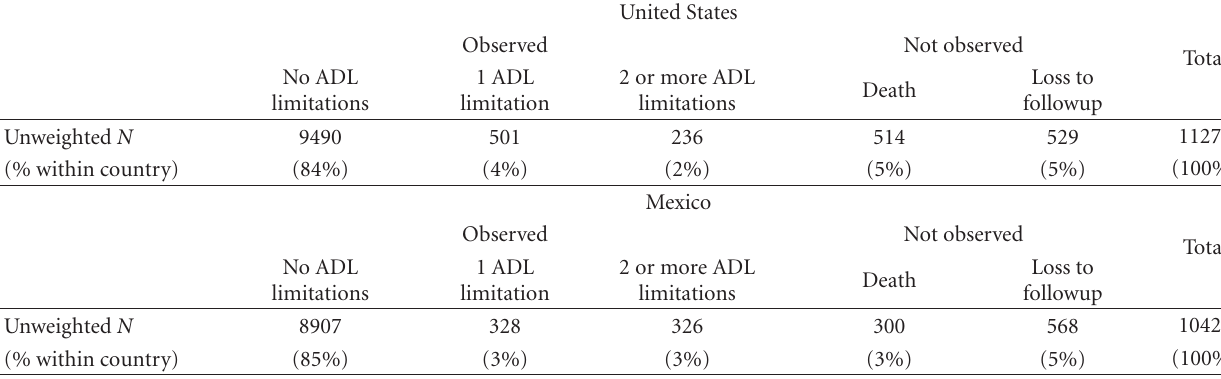
Table 1: Sample size for outcome at time 2 for persons with no ADL limitations at time